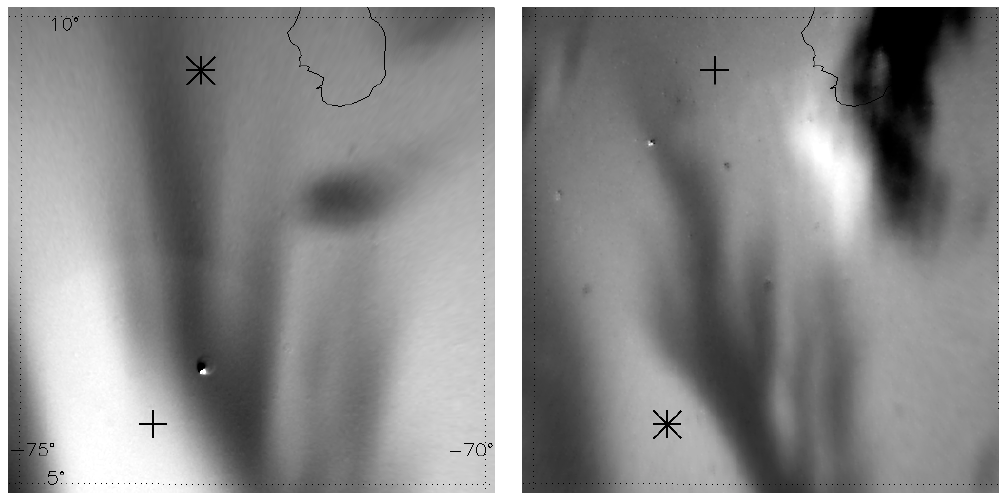
Figure 6. ( left ) 5 ° × 5 ° zoomed in region close to the zenith of the Villa de Leyva ASI, indicated as a plus symbol. The asterisk represents the conjugate location of El Leoncito’s zenith; ( right ) 5 ° × 5 ° zoomed in mapped region from El Leoncito ASI. The asterisk here represents the conjugate point of Villa de Leyva’s zenith and the plus symbol the location of El Leoncito’s zenith.